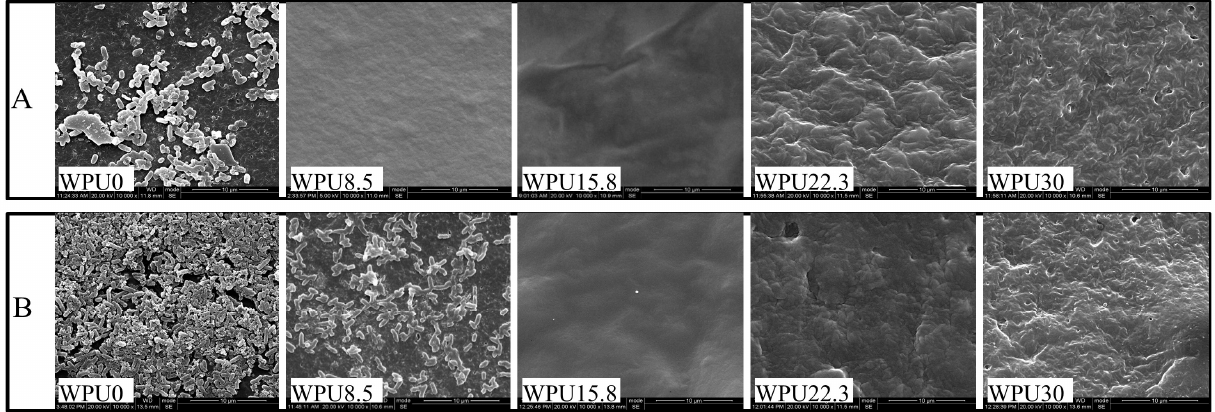
Figure 6. Morphology of E. coli attached to WPUn films (10,000×) after 2 days incubation in E. coli culture (10 7 CFU ∙ mL − 1 ). ( A ) LB media; ( B ) LB + 0.5% casamino acids media. Scale bar = 10 μ m.